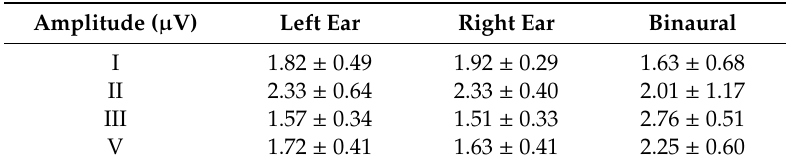
Table 3. Brainstem auditory evoked potentials amplitudes for waves I, II, III and V (in µ V) in healthy adult anesthetized raccoon